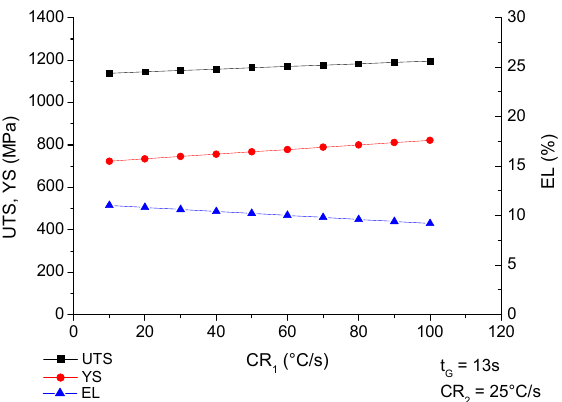
Figure 7. E ff ect of CR 1 on mechanical properties of dual phase (DP) steel. Calculations with statistical models.